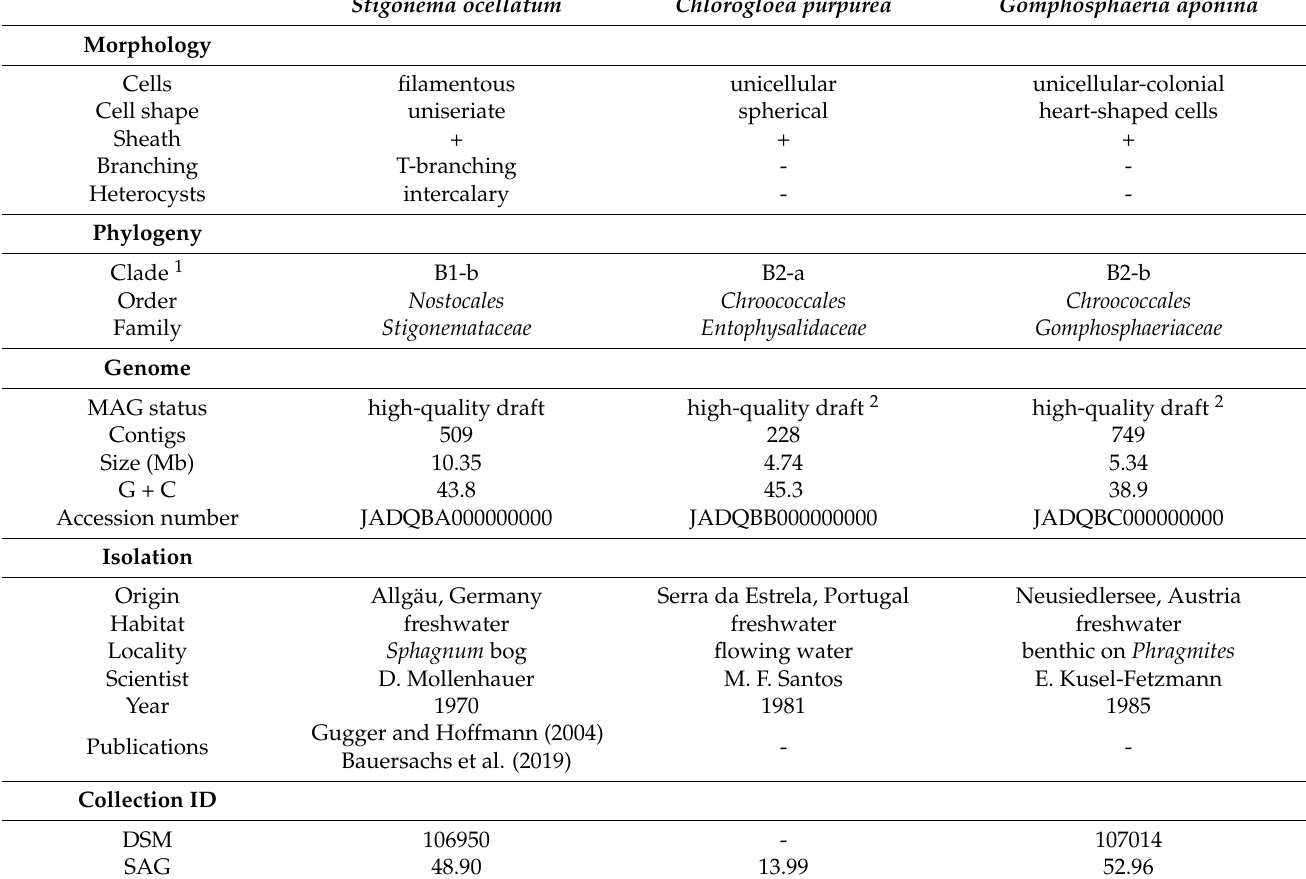
Table 1. Morphologic, genetic and biogeographic characteristics of three freshwater cyanobacteria. Stigonema ocellatum Chlorogloea purpurea Gomphosphaeria